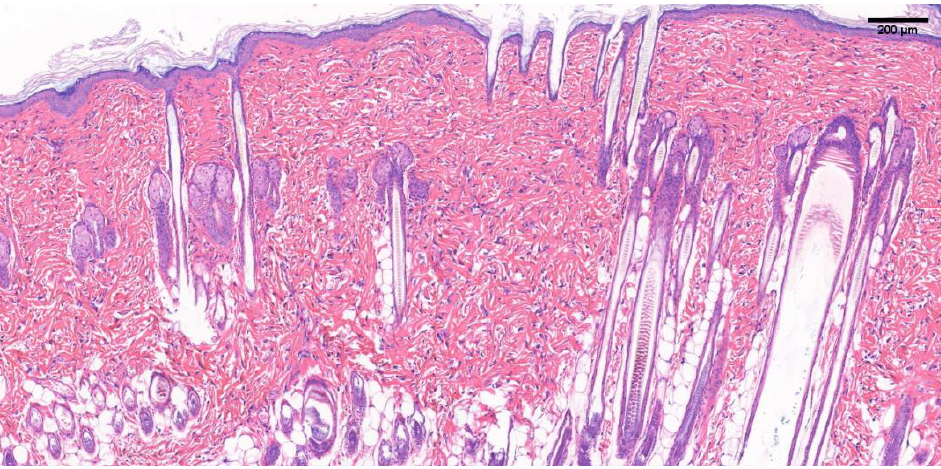
Figure 7. H&E staining image of normal skin tissue of SD rats. Scale bar = 200